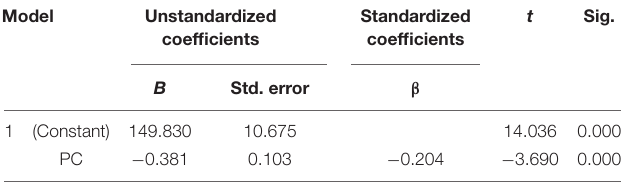
TABLE 8 | Coefficients for Chinese EFL PC and